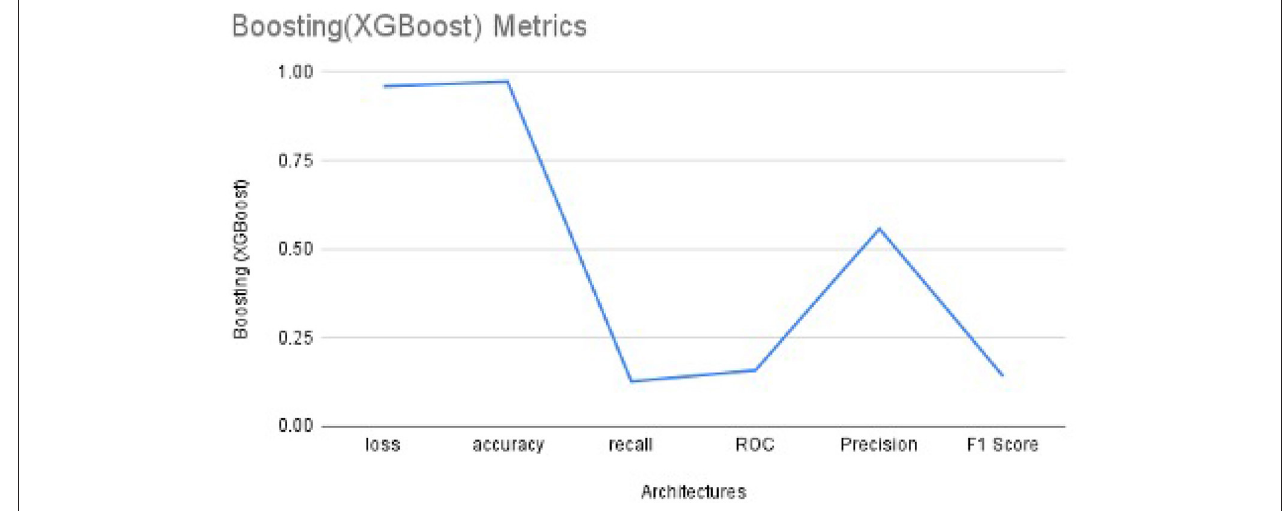
FIGURE 7 | The Performance metrics of XG-Boost with one epoch.